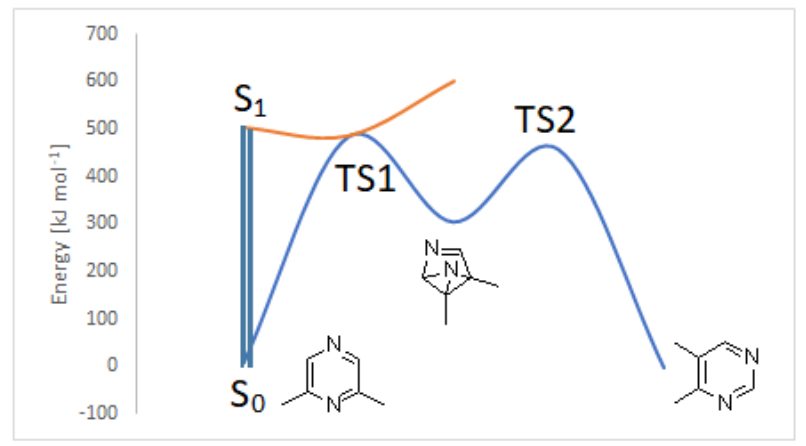
Figure 4. Transition state of the conversion of 5 into 2 .